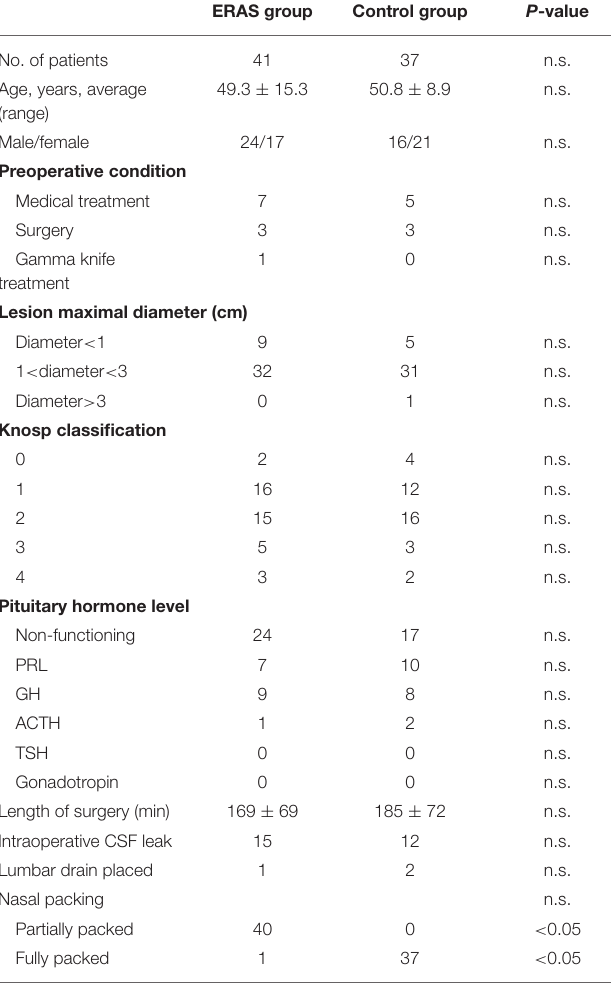
TABLE 2 | Preoperative patient